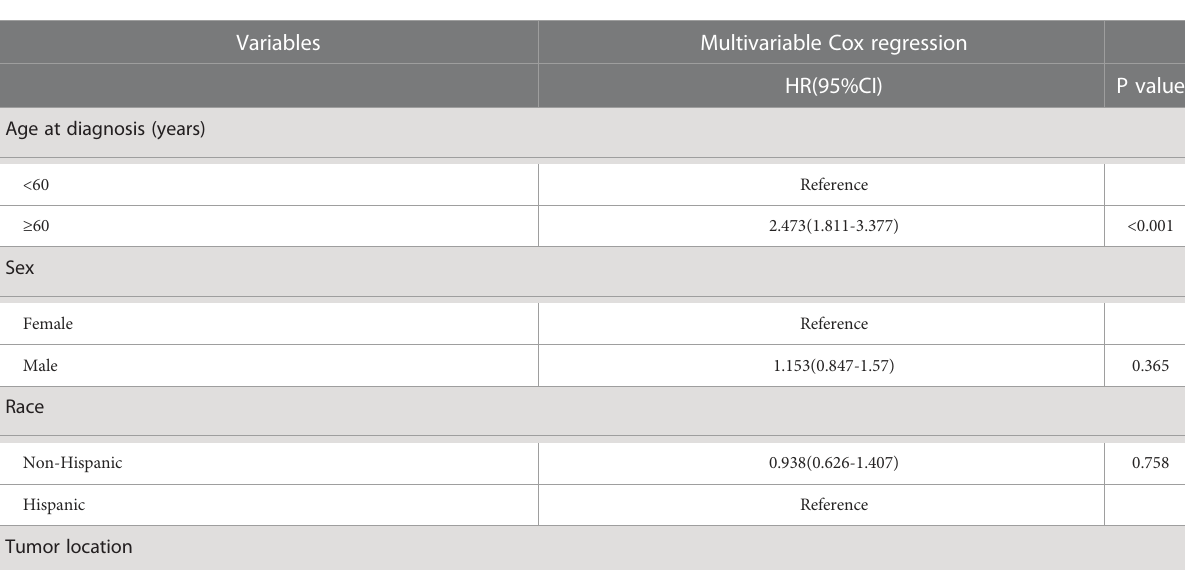
TABLE 3 Results of multivariable Cox regression.